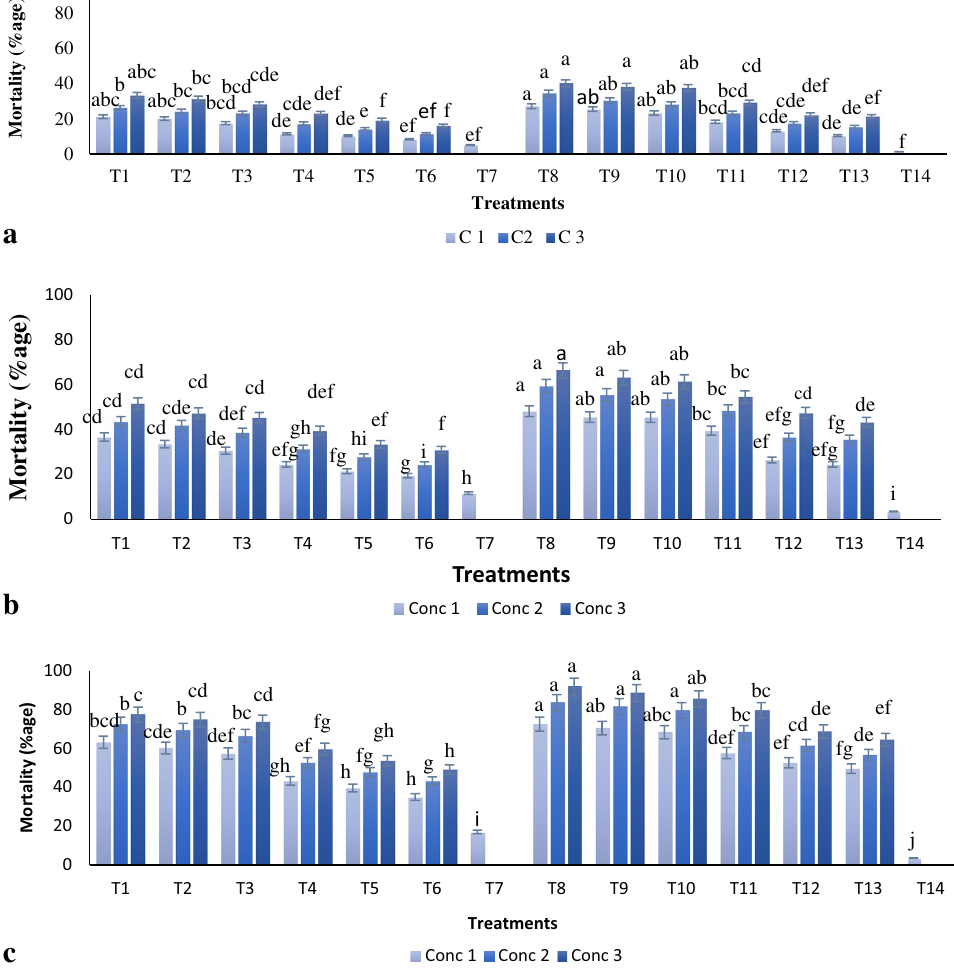
Figure 2. ( a ) Percentage mortality of cotton aphid 24 h post individual and combined treatment applications. Letters above the bars indicate differences between treatments as determined by ANOVA followed by Tukey HSD. Those not sharing a letter are significantly different (p < 0.05). The combined applications show significantly greater mortality than individual treatments and control. (C1 (F = 23.0; df = 13, 28; p < 0.000), C2 (F = 37.1; df = 13, 28; p < 0.0000), C3 (F = 75.0; df = 13, 28; p < 0.0001). ( b ) Percentage mortality of cotton aphid 48 h post individual and combined treatment applications. Letters above the bars indicate differences between treatments as determined by ANOVA followed by Tukey HSD. Those not sharing a letter are significantly different (p < 0.05). The combined applications show significantly greater mortality than individual treatments and control. (C1 (F = 93.1; df = 13, 28; p < 0.000), C2 (F = 163; df = 13, 28; p < 0.0000), C3 (F = 80.8; df = 13, 28; p < 0.0001). ( c ) Percentage mortality of cotton aphid 72 h post individual and combined treatment applications. Letters above the bars indicate differences between treatments as determined by ANOVA followed by Tukey HSD. Those not sharing a letter are significantly different (p < 0.05). The combined applications show significantly greater mortality than individual treatments and control. (C1 (F = 173; df = 13, 28; p < 0.000), C2 (F = 288; df = 13, 28; p < 0.0000), C3 (F = 321; df = 13, 28; p <